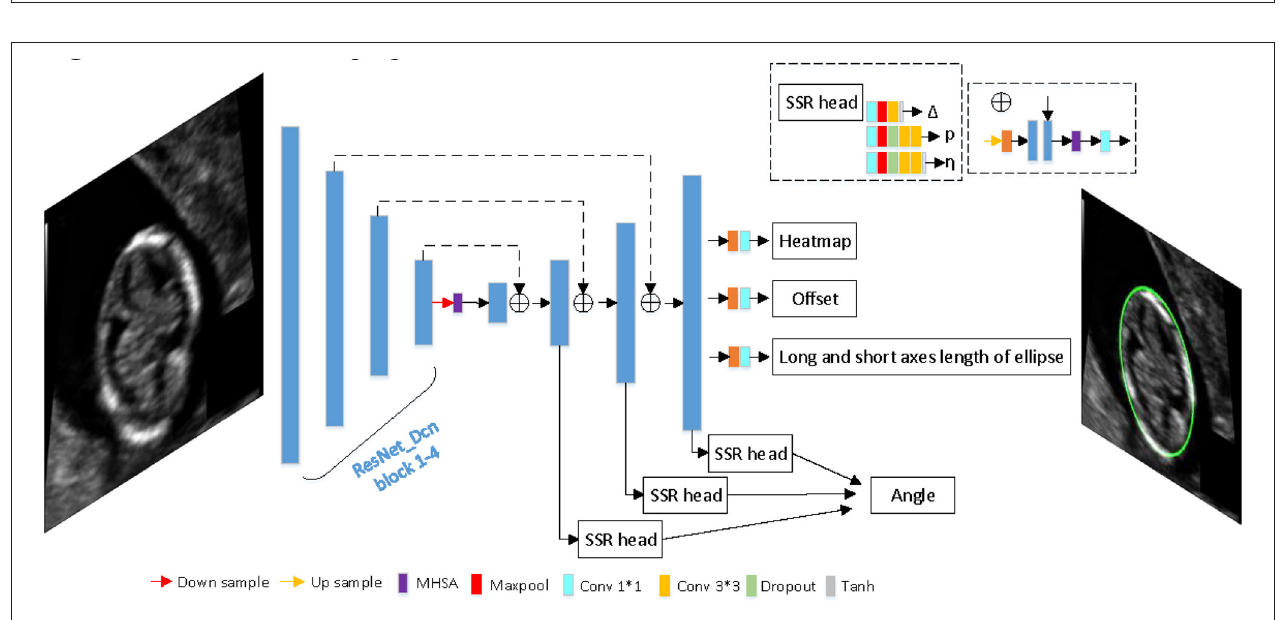
FIGURE 1 | The process comparison between our method and general detection method.